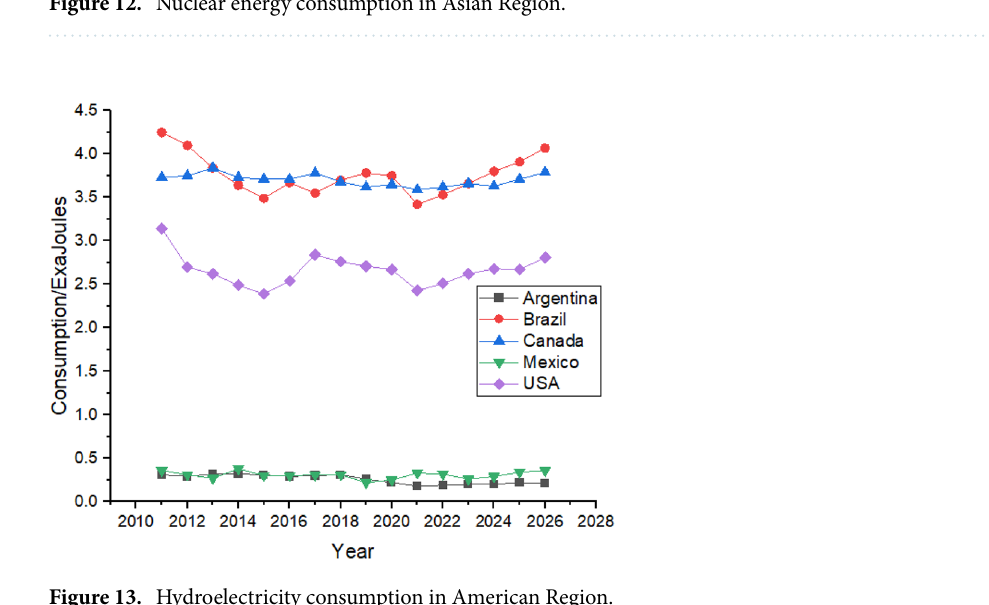
Figure 13. Hydroelectricity consumption in American Region.